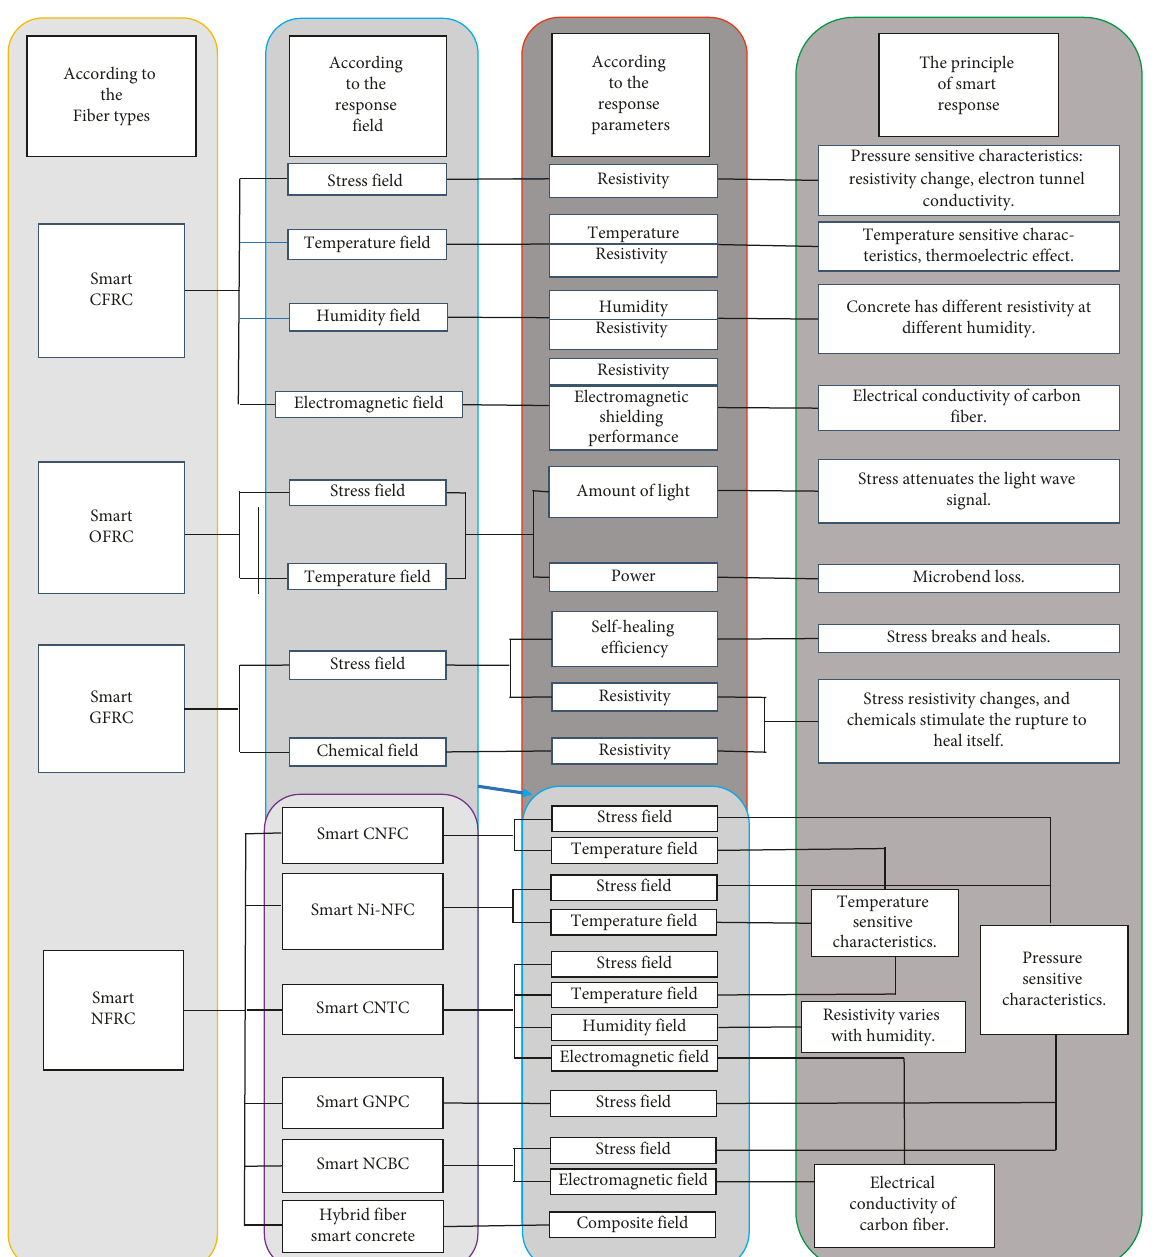
Figure 5: Environmental response mechanism map of smart FRC.